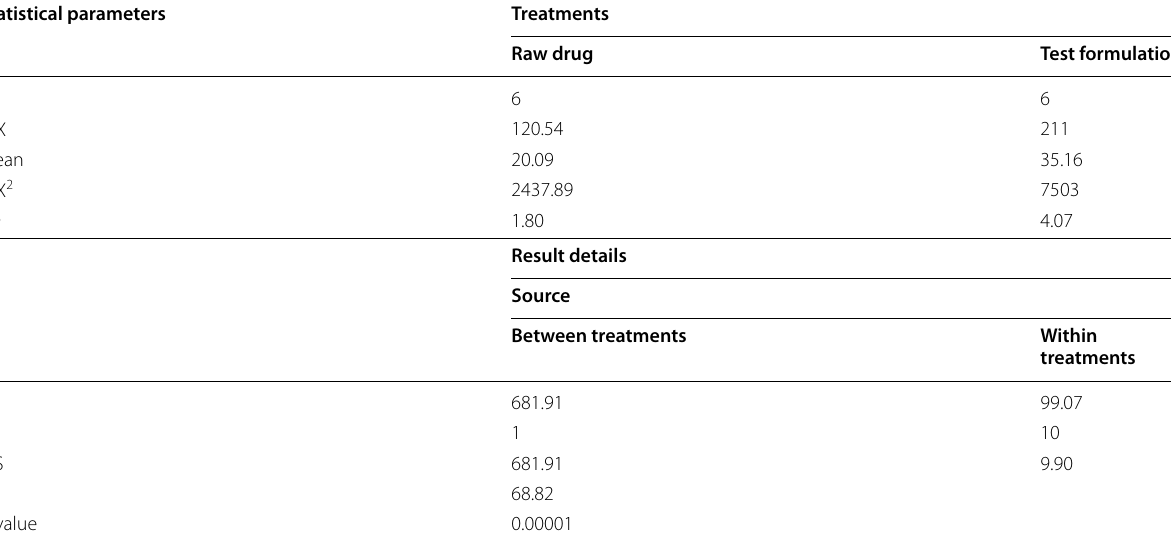
*N–No. of sample, ∑ X sum of sample, ∑ X 2 sum of sample square, SD standard deviation, SS sum of square, df degree of freedom, MS mean square, F test in one-way